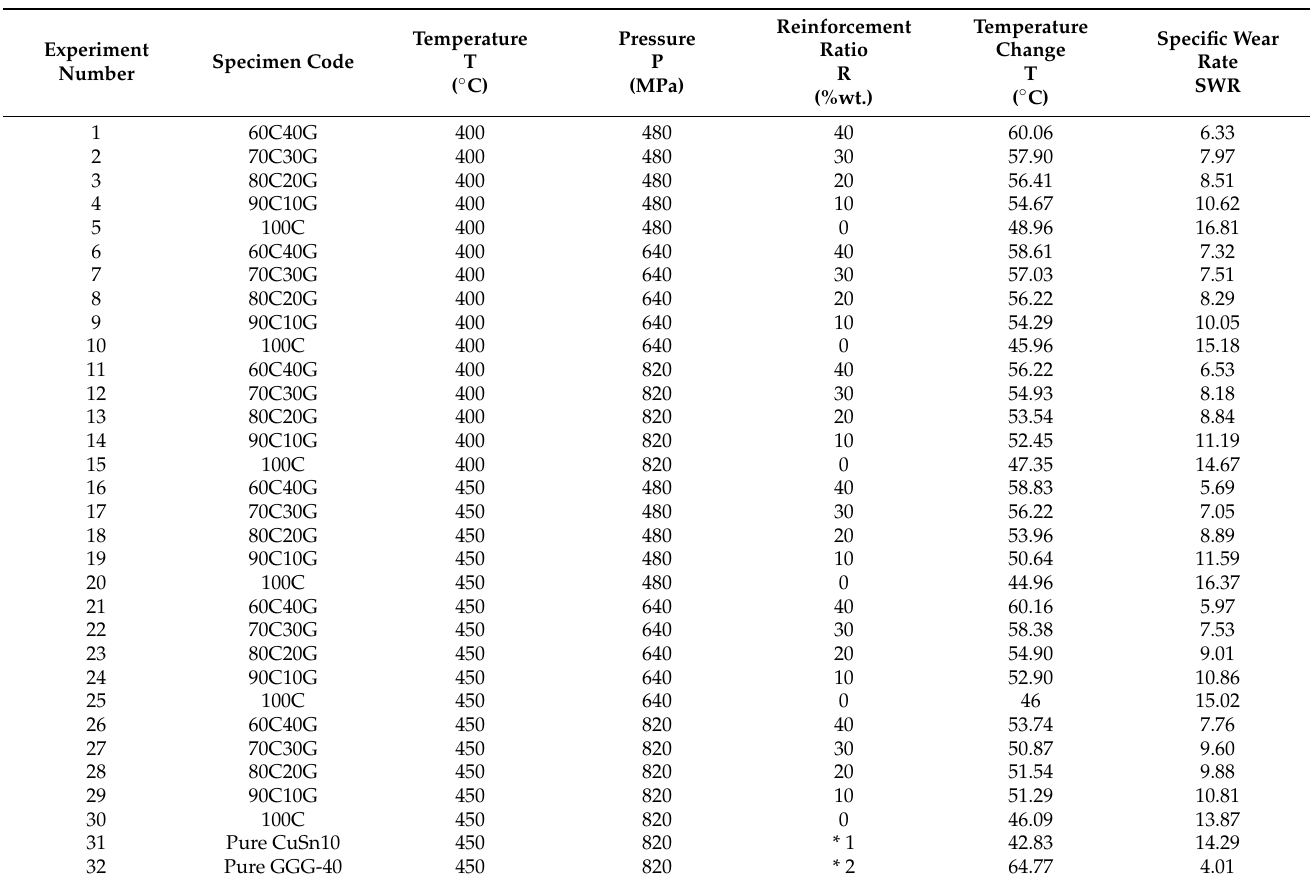
Table 3. Experimental